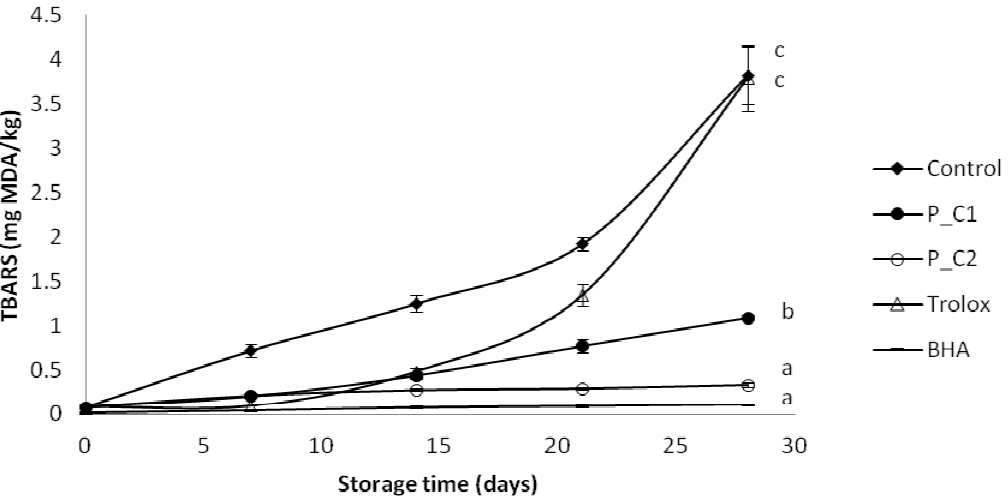
Figure 3. Evolution of secondary oxidation (TBARs) in model food system (O/W emulsion 10% of oil) with different concentration of perilla ethanolic extracts (C1: 80 ppm and C2: 320 ppm).